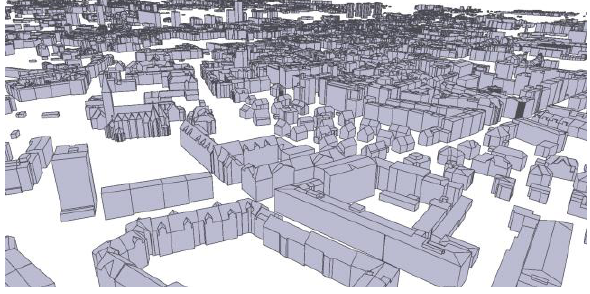
Figure 8. 3D city model in the geoJSON